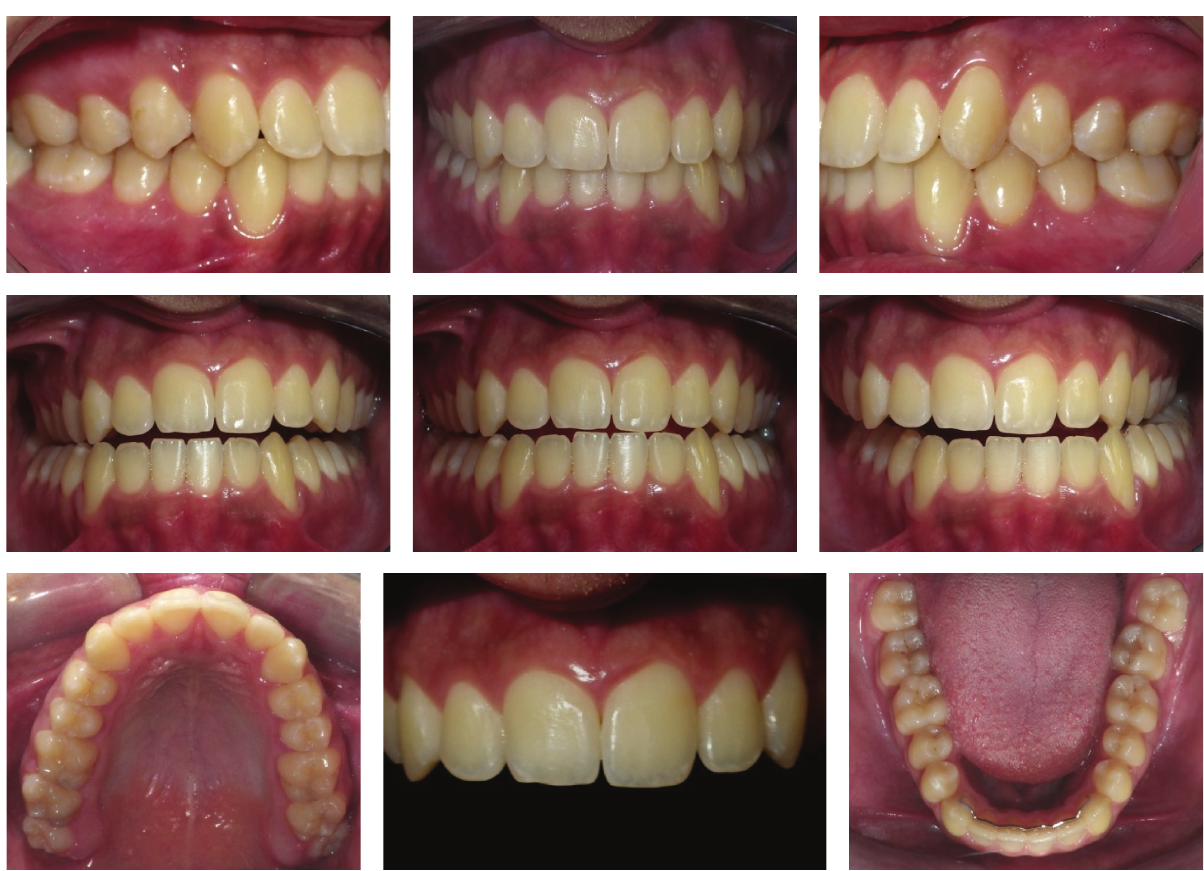
Figure 5: Two years nine months of posttreatment follow-up. Stability of the functional and occlusal results. Eruption of the third molars.